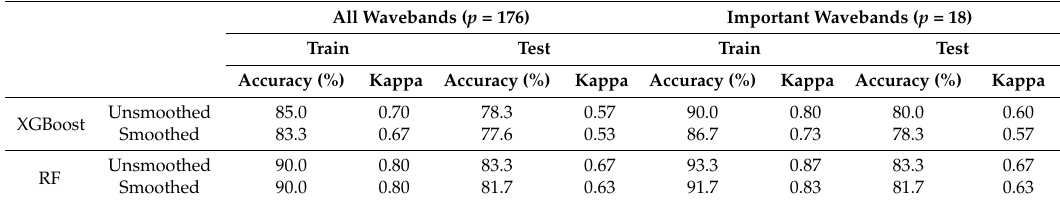
Table 3. Classification accuracies of both the RF and XGBoost models constructed using all the wavebands and the subset of important